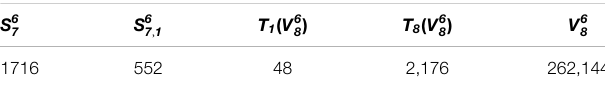
TABLE 2 | Degrees of freedom for the full space S d g , the TT variant S d g , ρ maximal block size ρ max (cid:1) 1, the space T r ( V d p ) with TT rank bounded by r (cid:1) 1, the space T r ( V d p ) with TT rank bounded by r (cid:1) 8, and the full space V d p for